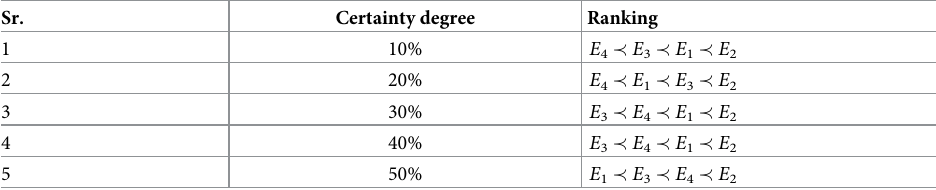
Table 3. HVaR results under PHF environment. Sr.